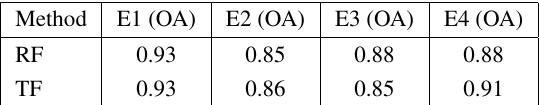
Table 4. Supervised benchmark - 11 time steps and 9 bands: Overall accuracy (OA) with all data; OA with 0% labels for 2018; with 5% labels and 10% for 2018.